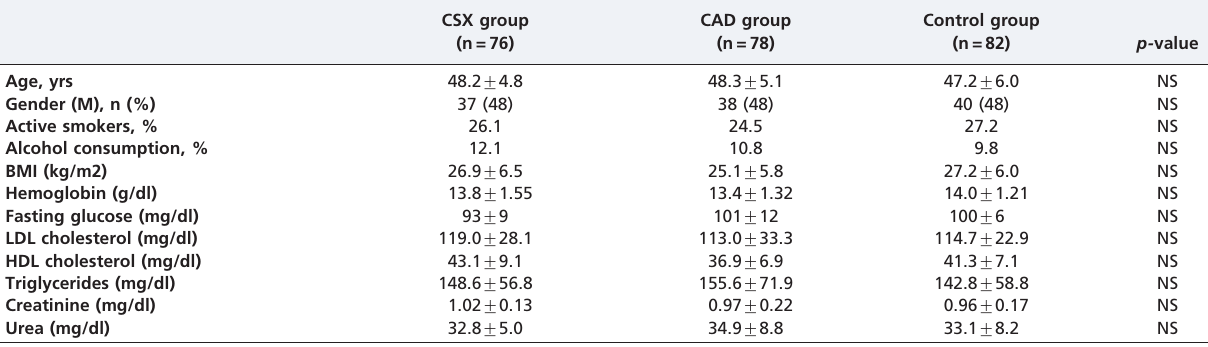
Table 1 - The baseline clinical and biochemical characteristics of the study groups.